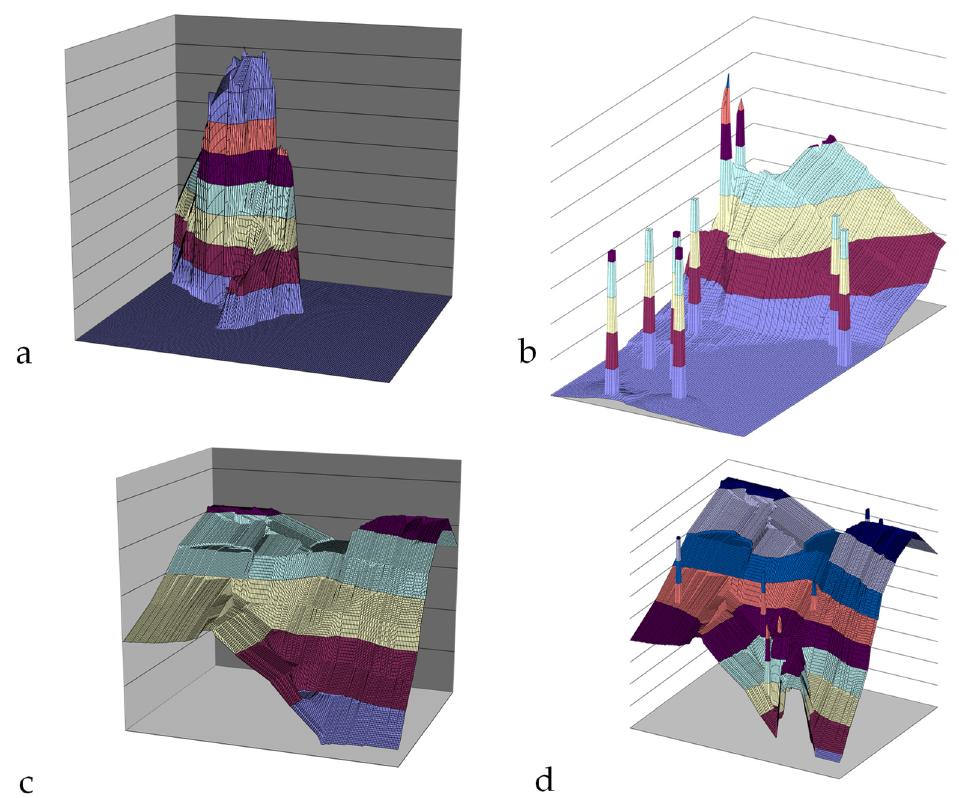
Figure A19. Potentiometric surface associated with conventional infiltration devices, discharging to an unconfined aquifer. ( a ), Example of the potentiometric surface associated with an infiltration device. ( b ), Example of an irregular potentiometric surface receiving water from nine infiltration devices; ( c ), Example of an irregular potentiometric surface; ( d ) Example of an irregular potentiometric surface, following the installation of infiltration devices.